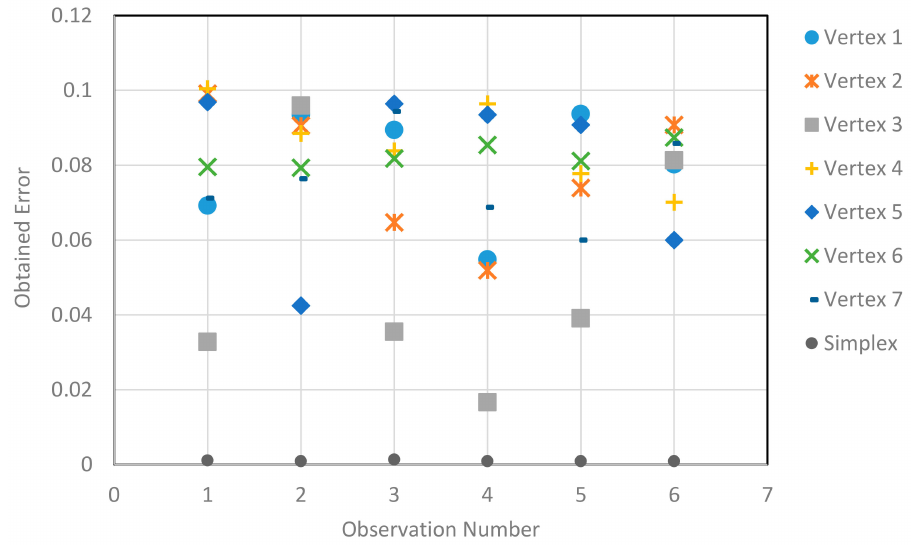
Figure 14. Reduction in error on applying simplex optimization on solutions obtained from PSO.